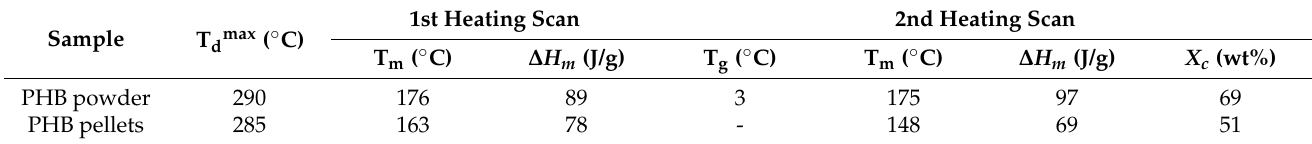
Figure 4. TGA curves of PHB powder and pellets samples. Table 2. Thermal properties of PHB powder and pellet samples.